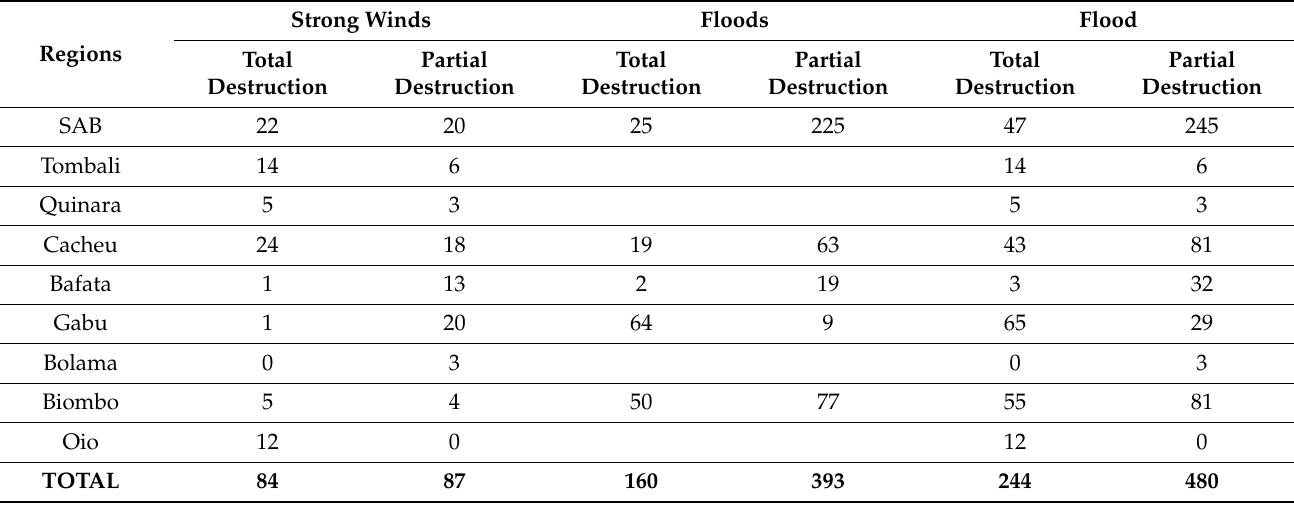
Table 3. Number of homes completely and partially destroyed, by region, caused by strong winds and flooding. Source: National Civil Protection Service, Guinea